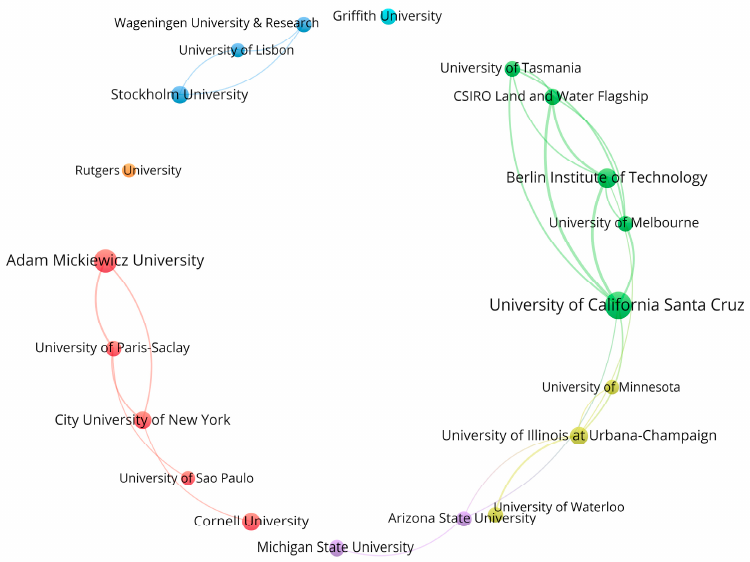
Figure 7. Collaboration network analysis of top 20 productive institutions.